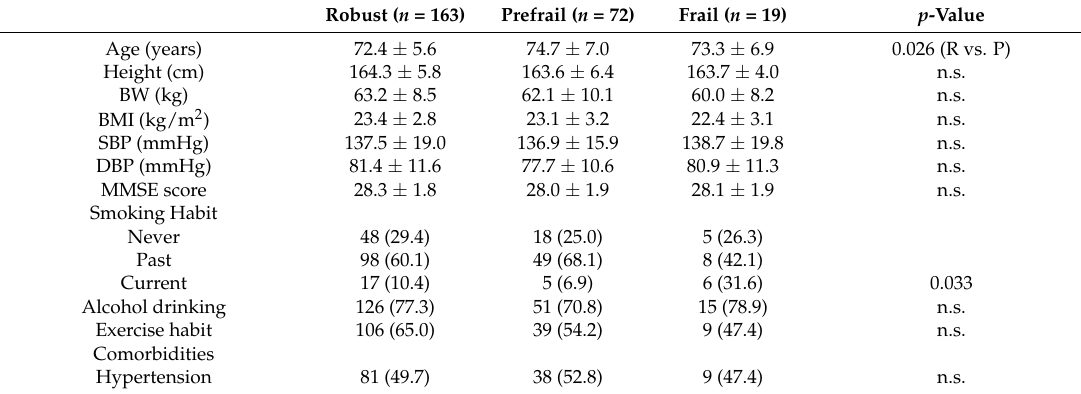
Table 2. Basic characteristics and dietary habits among frail, prefrail, and robust men, as diagnosed by the KCL